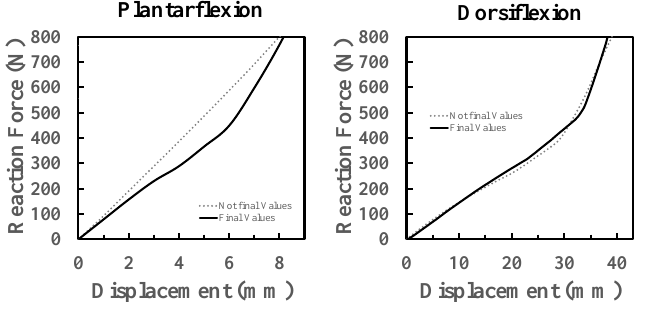
Figure 22. The stiffness curves presented as foot rotation–reaction force in Figure 21 can be also presented as platform displacement–reaction force